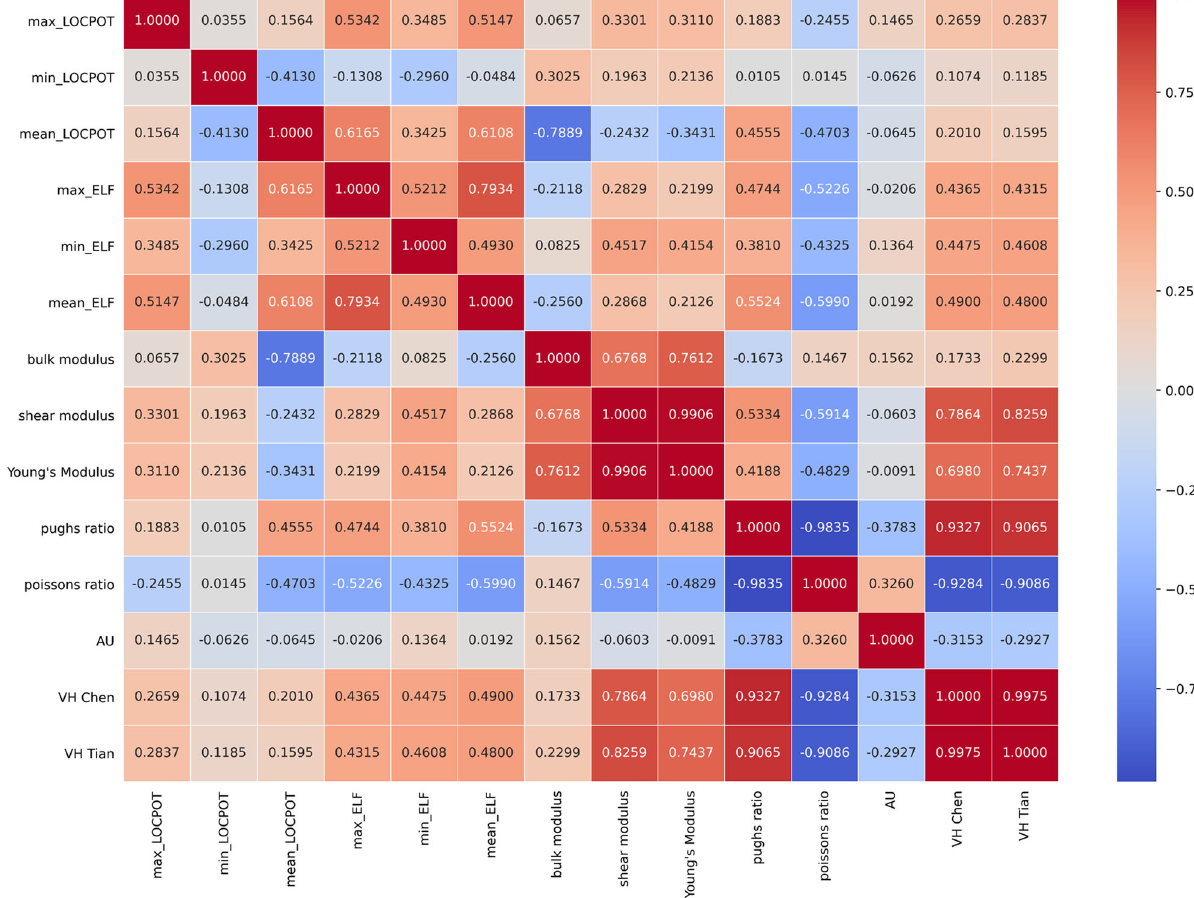
Fig. 8 Material descriptor analysis. Pearson correlation matrix between maximum local potential, minimum local potential, mean local potential, maximum electron localization function, minimum electron localization function, mean electron localization function, bulk modulus, shear modulus, elastic modulus Pugh ’ s ratio, and Poisson ’ s